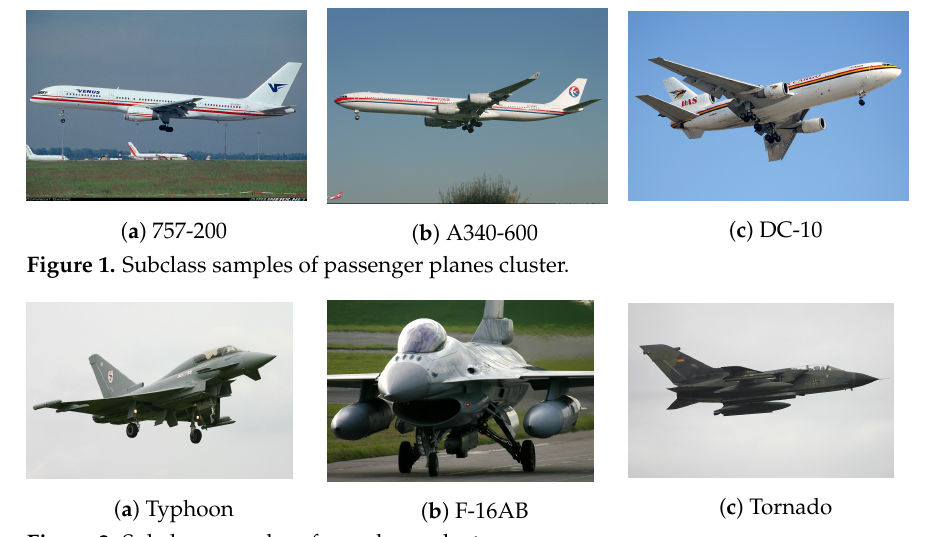
Figure 2. Subclass samples of warplanes